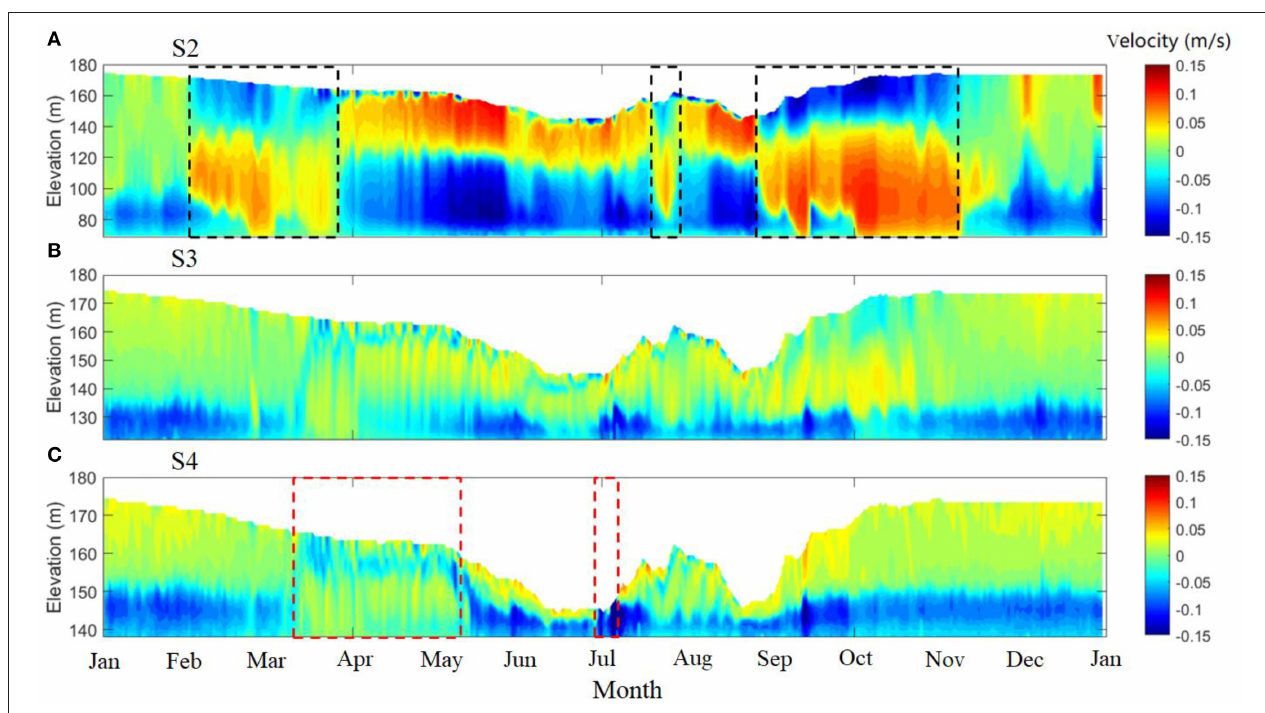
FIGURE 5 | Temporally simulated horizontal velocities at the mouth ( A , S2), middle ( B , S3), and upper ( C , S4) sites of Xiangxi Bay in 2012. Positive flow velocity corresponds to upstream flow (from TGR into the Xiangxi Bay); negative velocity is in the direction of the river flow. The black and red dotted boxes show the sharp shift of density currents,